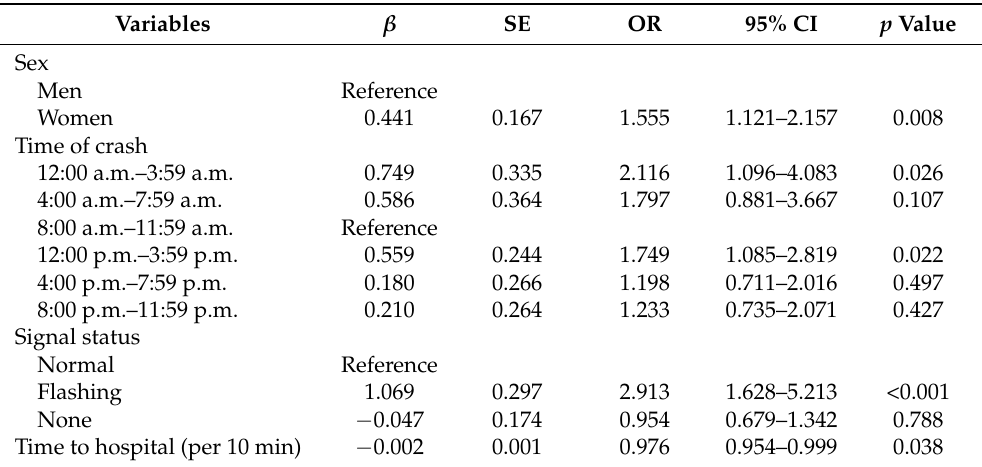
Table 3. Subgroup analysis between independent variables and severe injury (ISS ≥ 8) among young